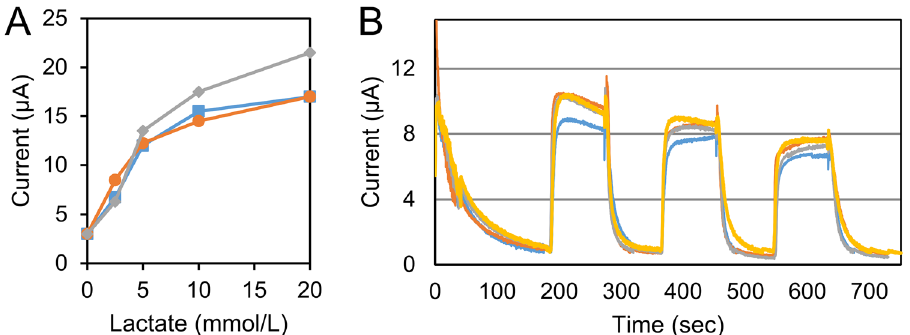
Figure 1. In-vitro characteristics of the sweat lactate sensor chip. ( A ) Amperometric response to increasing lactate concentration from 0 to 20 mM (0, 2.5, 5, 10, and 20 mM) in phosphate buffer (pH 7.0); the graph shows the corresponding calibration plots of the sensor. Applied voltage = 0.16 V versus Ag/AgCl. The data were obtained from three samples. ( B ) Reproducibility and long-term stability of the sweat lactate sensor; the graph shows amperometric response to l-lactic acid solution adjusted to 10 mM repeatedly three times for 90 s. Data recording was paused for 90 s for each response. The data were obtained from four